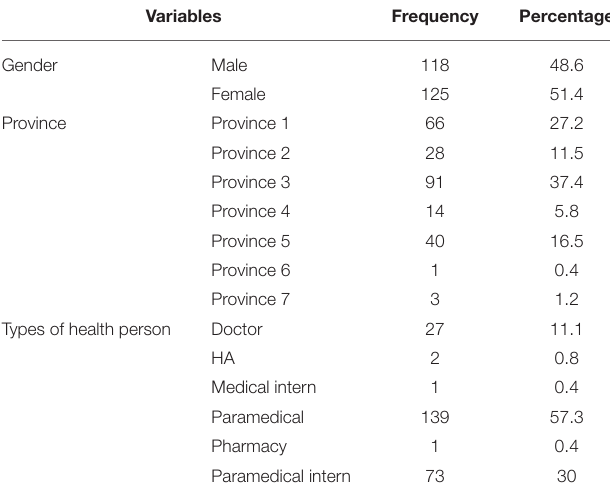
TABLE 1 | Socio-Demographic characteristics.